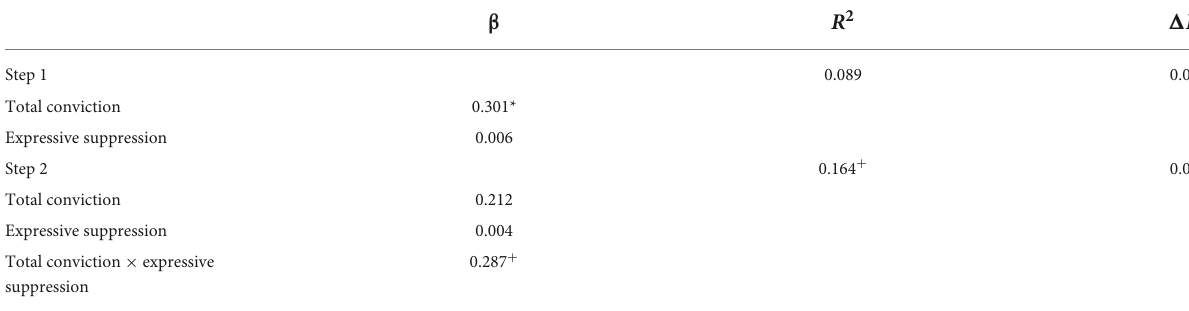
TABLE 3 Hierarchical multiple regression analysis with expressive suppression as a moderator variable.